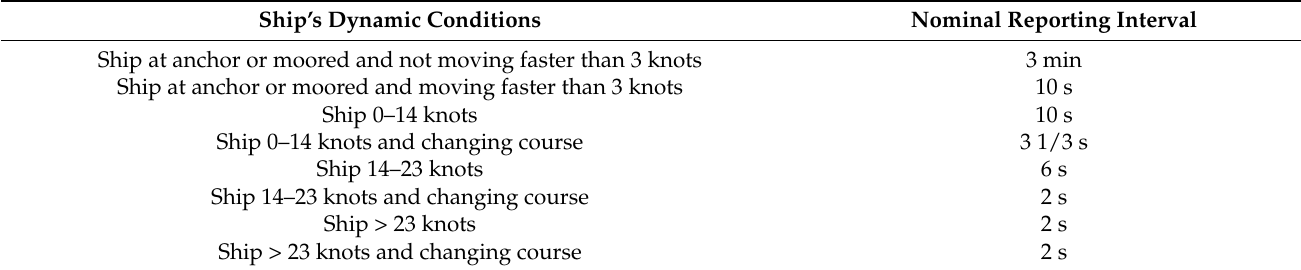
Table A1. Class A shipborne mobile equipment reporting intervals.